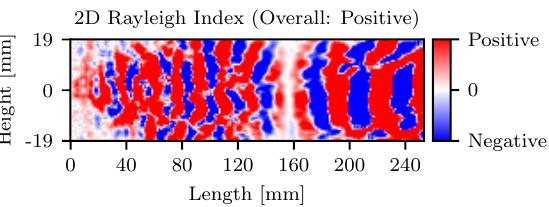
Figure 17. 2D Rayleigh Index of the chamber’s first longitudinal resonance mode based upon CH* radiation for the second interval in